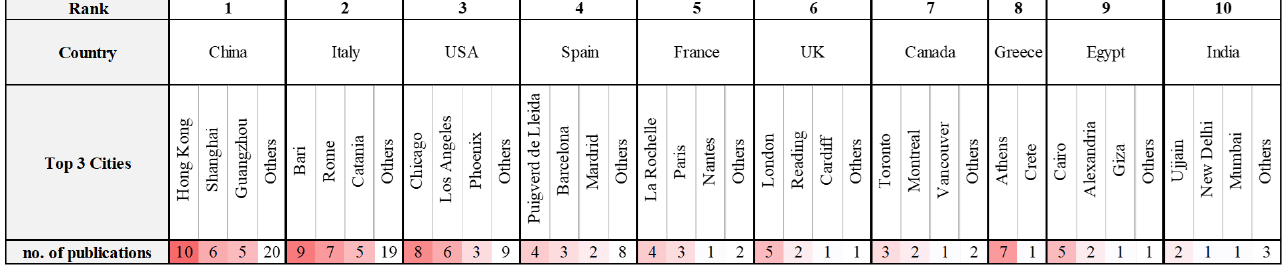
Figure 6. The ranking of the top 10 countries with the most UGI research publications, published between 2010 and 2021, with additional information on the top 3 cities in each country.